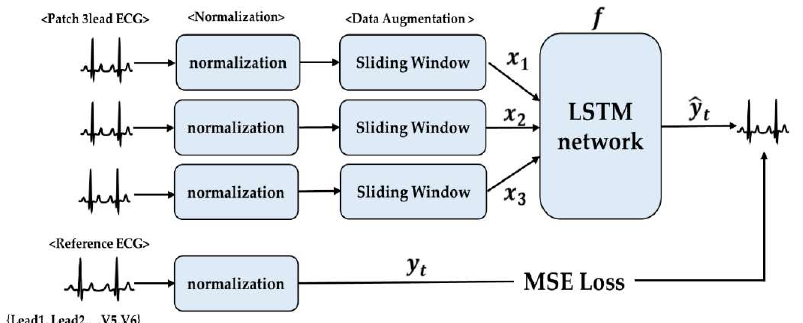
Figure 4. Flow of the proposed algorithm (x1: lead1 ECG data, x2: lead2 ECG data, x3: lead3 ECG data, MSE: mean square error). ECG: electrocardiogram.